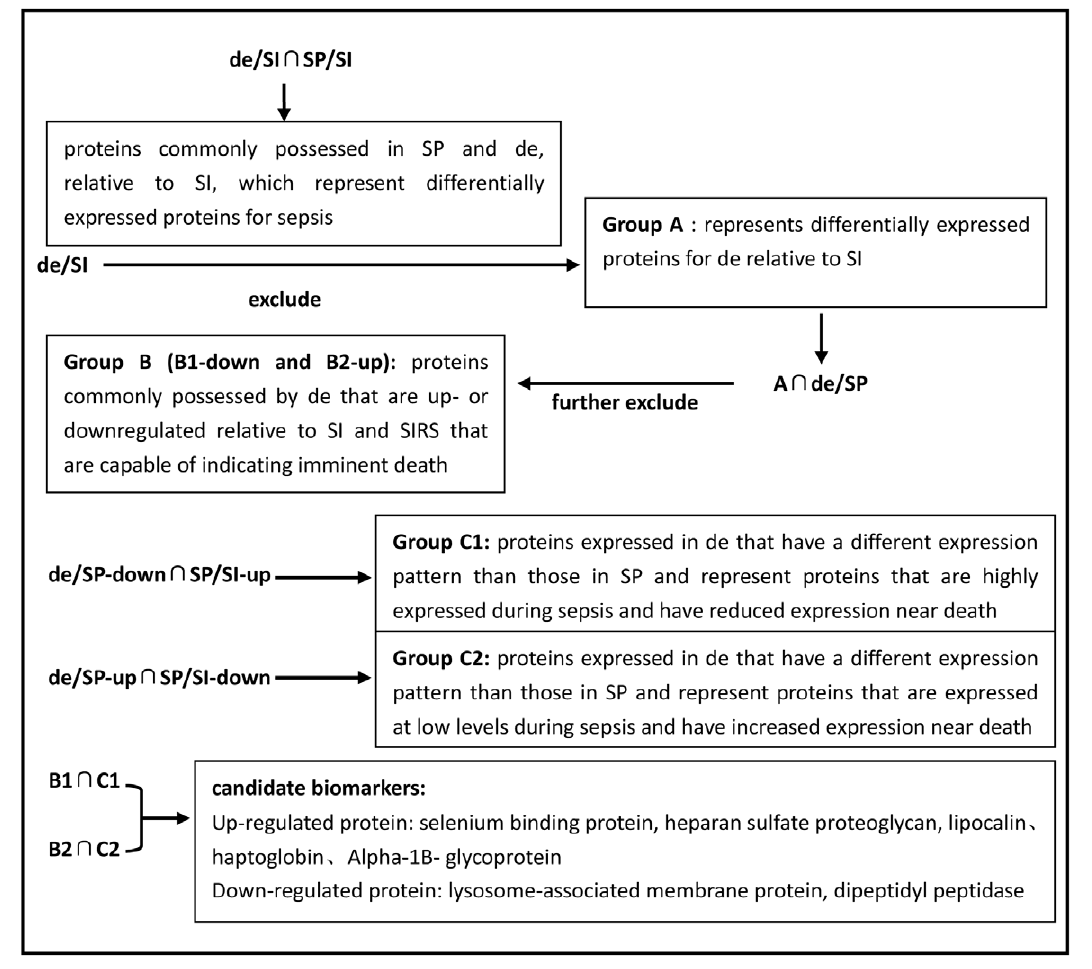
Figure 3. The analytical process for candidate target protein identification. SI: urine specimens from patients with SIRS. SP: urine specimens from sepsis patients, acquired within 24 h of admission to the ICU. de: urine specimens from sepsis patients, acquired within 48 h before death. de/SI: proteins differentially expressed in de relative to SI. de/SP: proteins differentially expressed in de relative to SP. SP/SI: proteins differentially expressed in SP relative to SI.